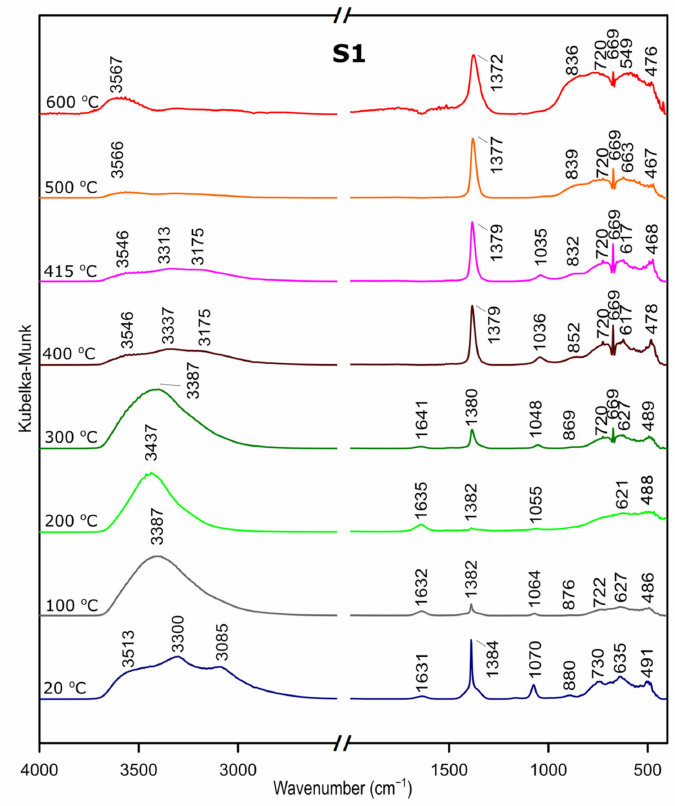
Figure 5. DRIFTS results for the sample S1.